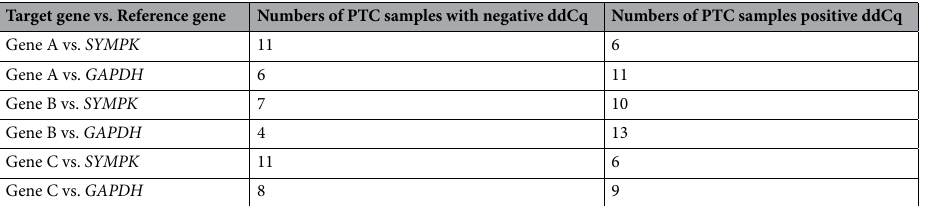
Table 8. Single PTC sample analysis using ddCq method. Normalization of Gene A against SYMPK reveals that 11 of the 17 PTC samples have negative ddCq, while the remaining six have positive ddCq. When Gene A is normalized against GAPDH, the results are flipped, with six PTC samples exhibiting negative ddCq and eleven exhibiting positive ddCq. Gene B and Gene C also have opposing patterns. PTC samples with positive ddCq mutually neutralize PTC samples with negative ddCq, resulting in a change in the overall expression pattern of a target gene. Each PTC sample is compared with its adjacent normal tissue.ddCq: delta-delta